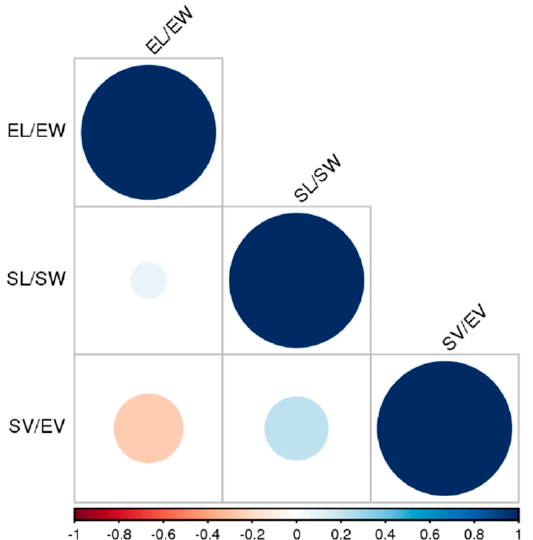
Figure 2. Correlation matrix between the studied morphological aspects. AS = air-space, EW = embryo width, EV = embryo volume, SL = seed length, SW = seed width, and SV = seed volume.